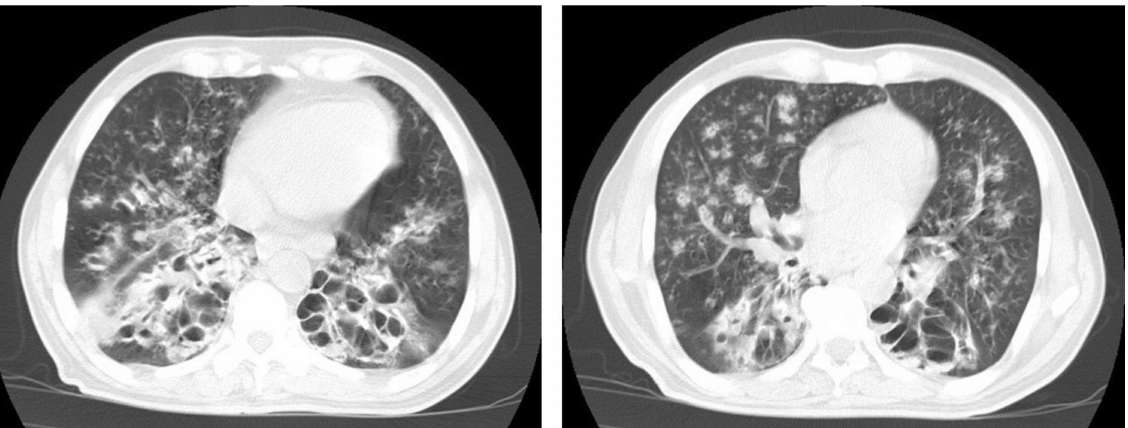
Figure 10. Reactivation of TB in an adult man with chronic cough. Selected axial images of lung CT show cystic bronchiectasis, due to old infection, with peribronchial thickening and air fluid level involving both lower lobes. Scattered tree in bud pattern and infected cystic bronchiectasis indicate active